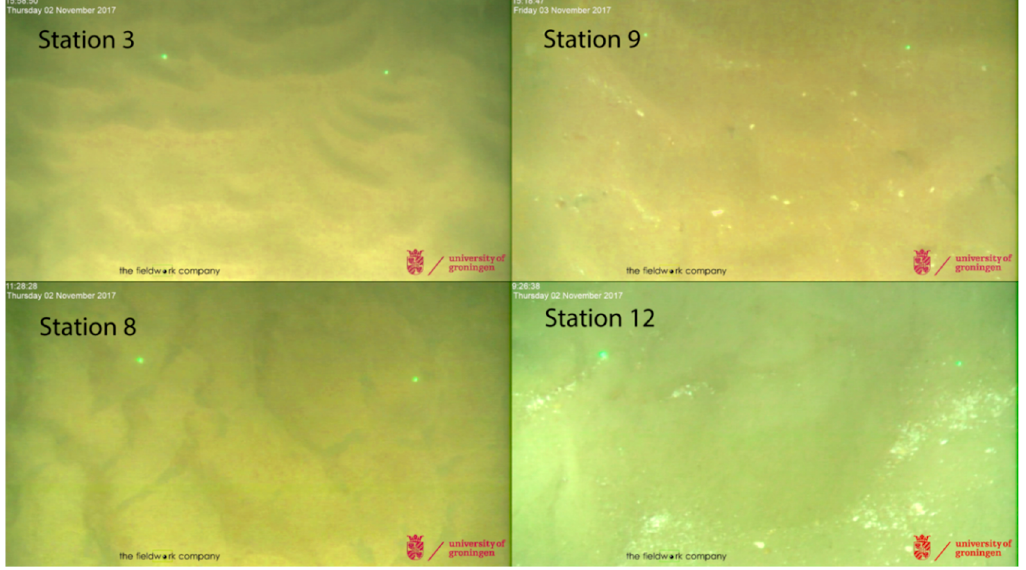
Figure 14. Video data presented as still images from stations 9 and 12 (in troughs) and 3 and 8 (on crest). Indicated in pictures are also two green dots representing a distance of ~20 cm, sand ripples having wavelengths of ~5 cm and other surficial structures/compositions.